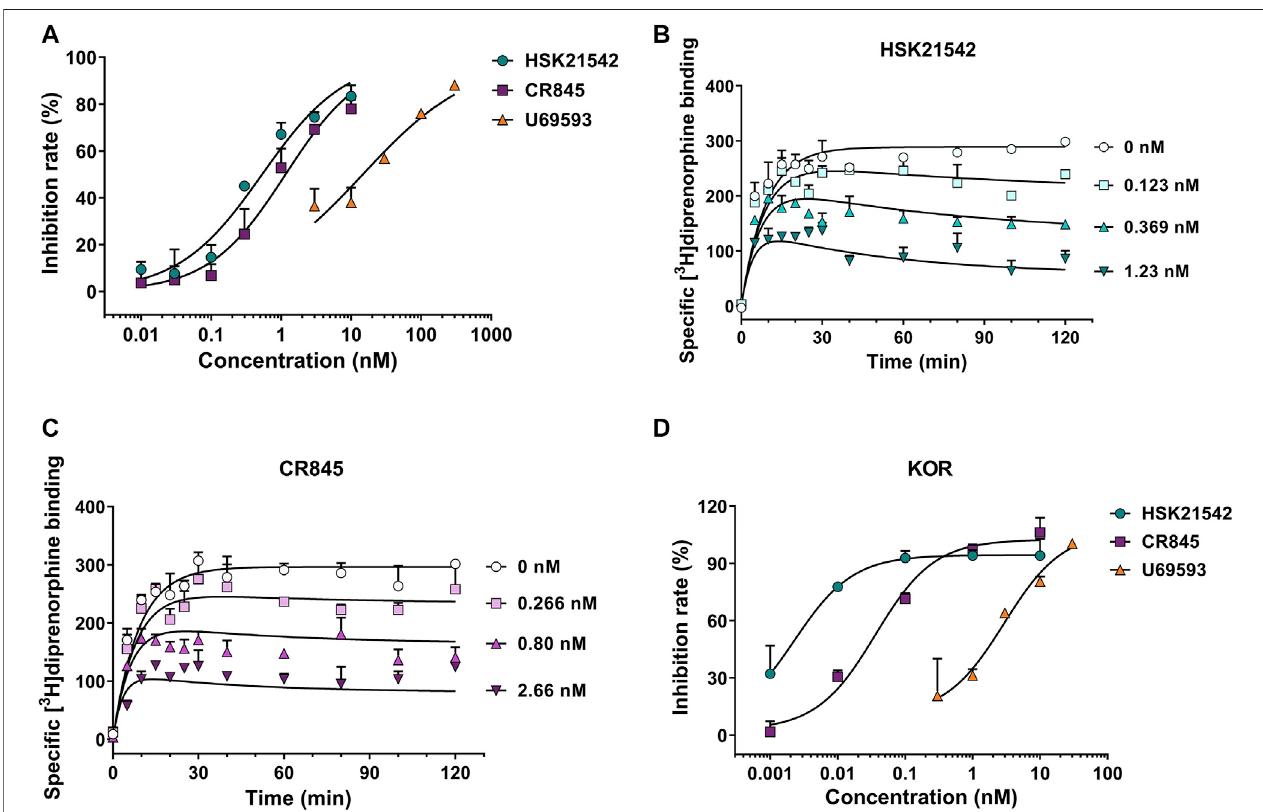
FIGURE 2 | Kappa opioid receptor binding af fi nity and the effects on forskolin-induced cAMP accumulation of HSK21542 and CR845. (A) Concentration-effect curves of the inhibitory rates induced by HSK21542, CR845 or U69593 (the positive control) on [ 3 H]diprenorphine binding to KOR. (B) The binding kinetic curves of HSK21542 binding to KOR. (C) The binding kinetic curves of CR845 binding to KOR. (D) Concentration-effect curves of the inhibitory rates induced by HSK21542, CR845 or U69593 (the positive control) on forskolin-induced cAMP accumulation. Data are presented as means ± SD of triple